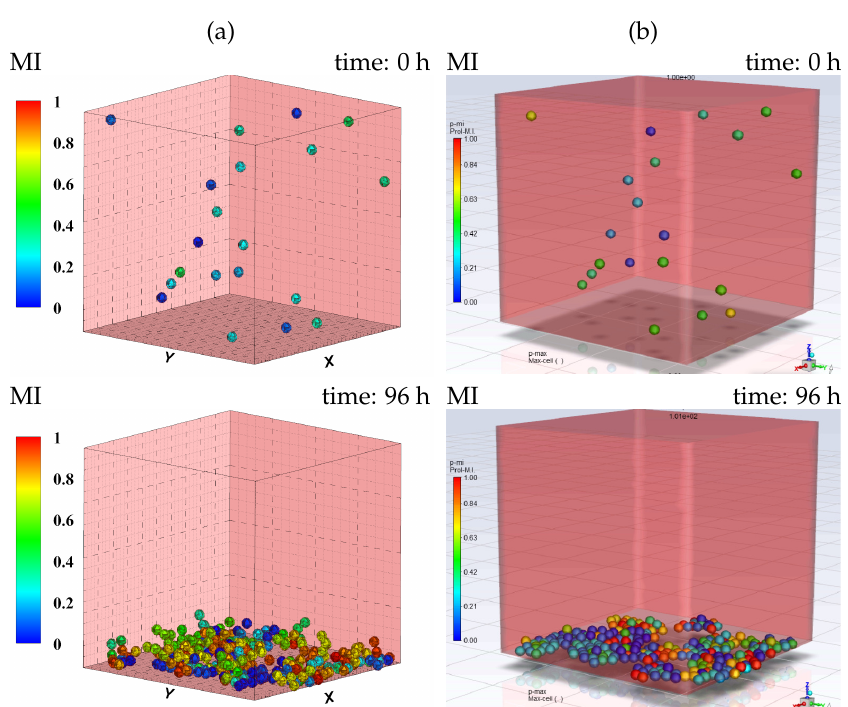
Figure 3. MI during 96 h of simulation using the ABQ ( a ) and ANS ( b ) models. MMCs were seeded in a random initial distribution, and at a random initial state of maturation ( top ). After 96 h of cell-in-culture simulation, MMC aggregates started to form ( bottom ) (see also Supplementary Material Videos S1 and S2).